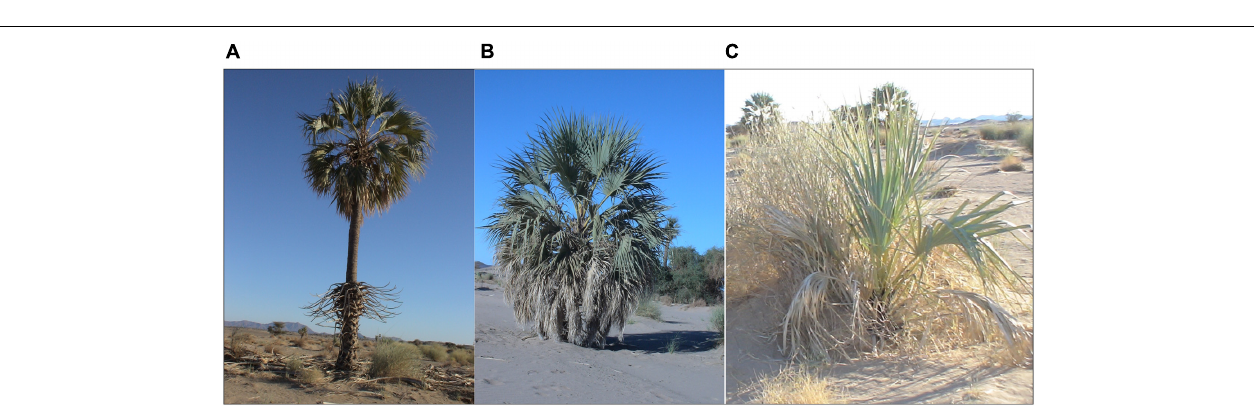
FIGURE 2 | Google Earth views of the collection site 1 (20 ◦ 48 (cid:48) 6.7 (cid:48)(cid:48) N, 34 ◦ 25 (cid:48) 29 (cid:48)(cid:48) E) and site 2 (20 ◦ 49 (cid:48) 2.3 (cid:48)(cid:48) N, 34 ◦ 23 (cid:48) 28 (cid:48)(cid:48) E) showing mountain ranges and the pattern of the distribution of M . argun individuals. The black small dots are M . argun palms.